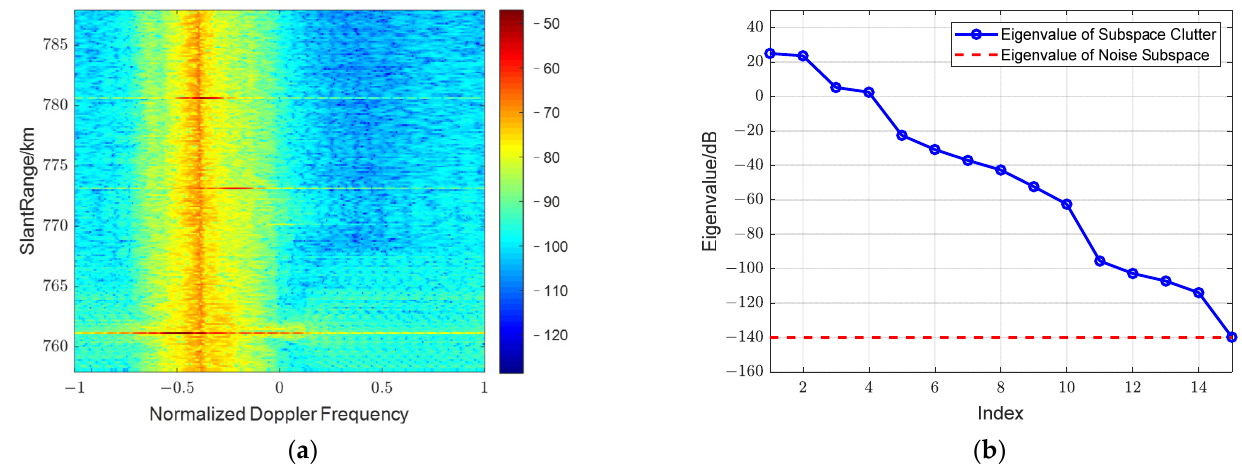
Figure 13. ( a ) The range-Doppler output power spectrum after using method 3.c; ( b ) The eigenvalue spectrum of reduced dimensional clutter covariance matrix.